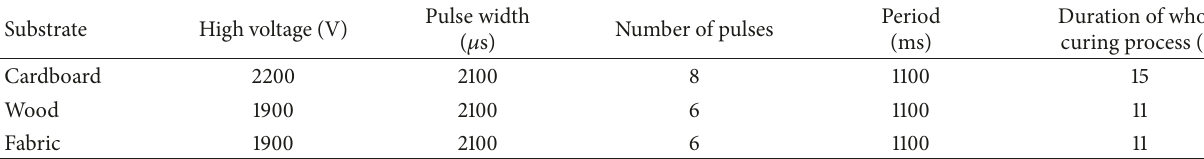
Table 2: Optimized photonic curing parameters for different substrate materials.